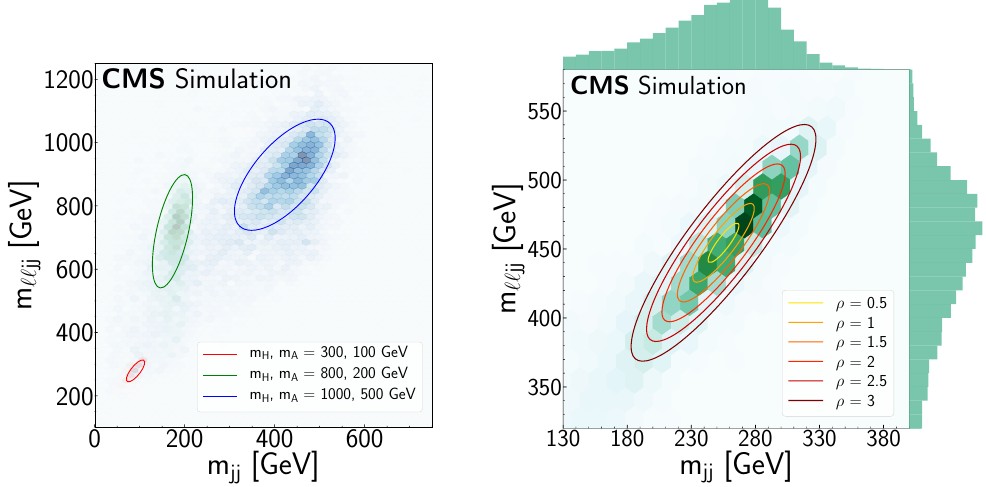
Figure 4 . The m vs. m plane for signal samples under three di(cid:11)erent mass hypotheses, ‘‘ jj jj on which the parametrised ellipses are shown (left). A signal hypothesis with m m = 300 GeV is shown in the m vs. m plane (right). The di(cid:11)erent ellipses show the variation A ‘‘ jj jj of the (cid:26) parameter in steps of 0.5, from 0 to 3. The intensity of the colour in each hexagonal bin is proportional to the number of events in